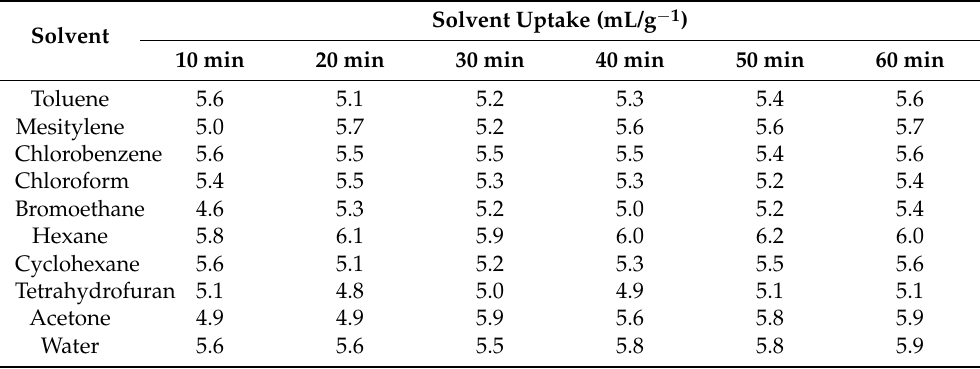
Table 1. Solvent adsorption by X-Ca-alginate aerogel beads at various time intervals. Solvent